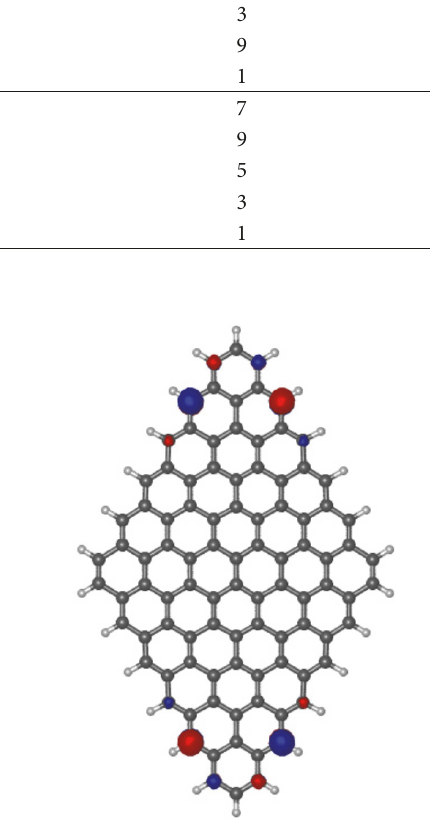
Figure 14: R 6 magnetic orbital 2.